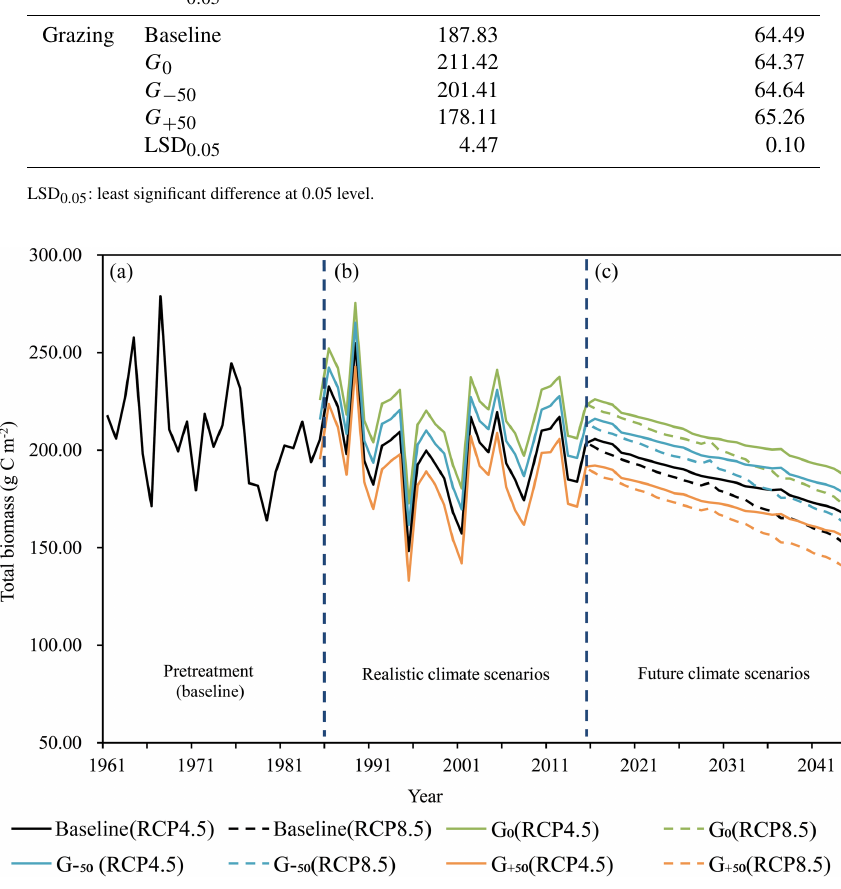
Figure 5. Variations in the area-weighted mean biomass value under different scenarios. Section (a) represents the preprocessing period from 1961 to 1984. Section (b) represents the realistic climate scenarios. Section (c) represents future climate